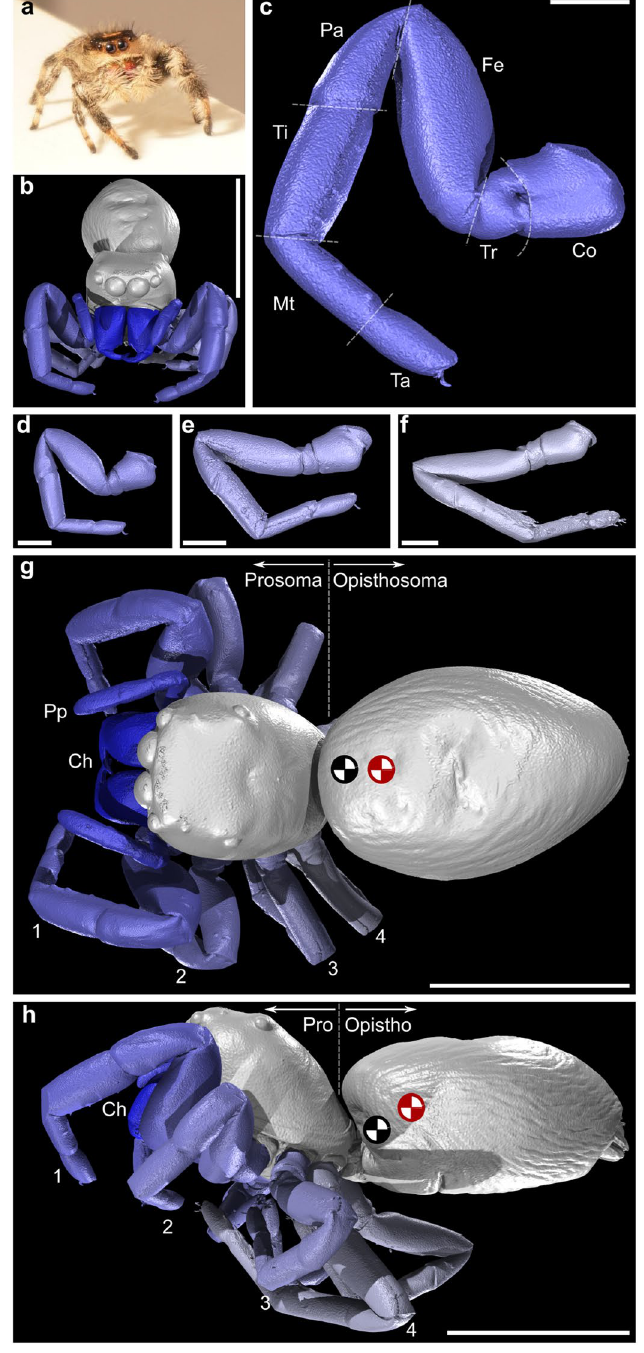
Figure 1. The morphology of the jumping spider Phidippus regius . ( a ) The individual used for the study of jumping performance. ( b – h ) Digital visualisations of a second specimen derived through X-ray microtomography: ( b ) Anterior view. ( c ) The first (anterior-most) walking leg. ( d – f ) The second, third and fourth walking legs, respectively. ( g ) Dorsal view. ( h ) Side view. Abbreviations: 1–4: walking legs 1–4; Ch: chelicerae; Co: coxa; Fe: femur; Mt: metatarsus; Pa: patella; Pp: pedipalps; Ta: tarsus; Ti: tibia; Tr: trochanter. Scale bars: b,g,h : 5 mm; ( c – f ) 1 mm. Red symbol denotes centre of mass of body alone whereas the black symbol denotes the centre of mass of the whole spider with the appendages in the position